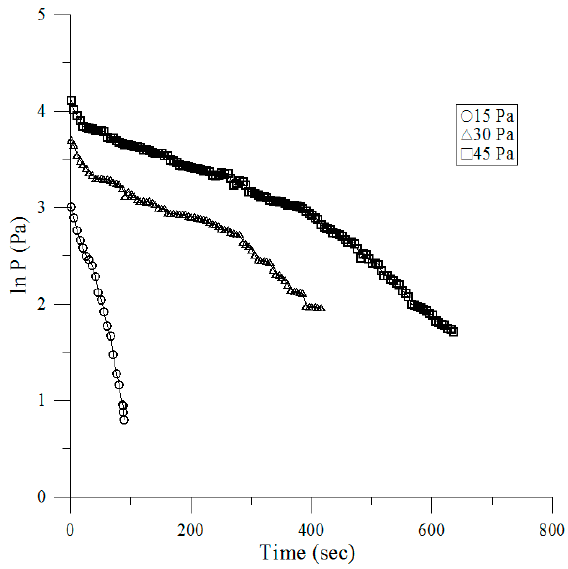
Figure 6. Pressure ( P ) versus time ( t ). Table 2. Correlations of pressure ( P ) vs. time ( t ).